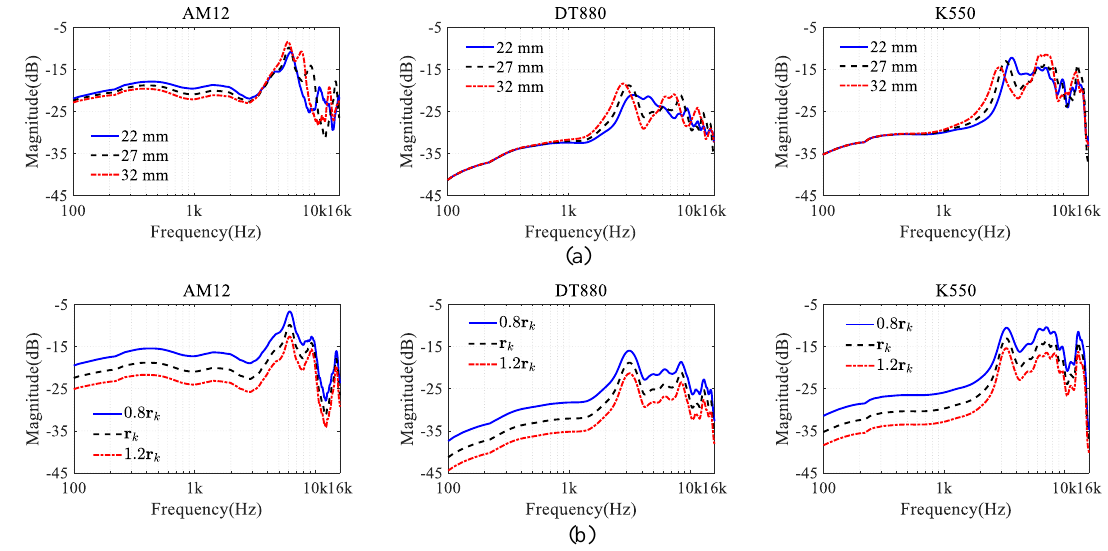
Figure 6. (Color online) The estimated HpTFs for three different types of headphones with different ear canal area functions. ( a ) Ear canal lengths of 22 mm, 27 mm, and 32 mm, respectively; ( b ) Ear canal radius of 0.8 r k (small), r k (normal), and 1.2 r k (large),